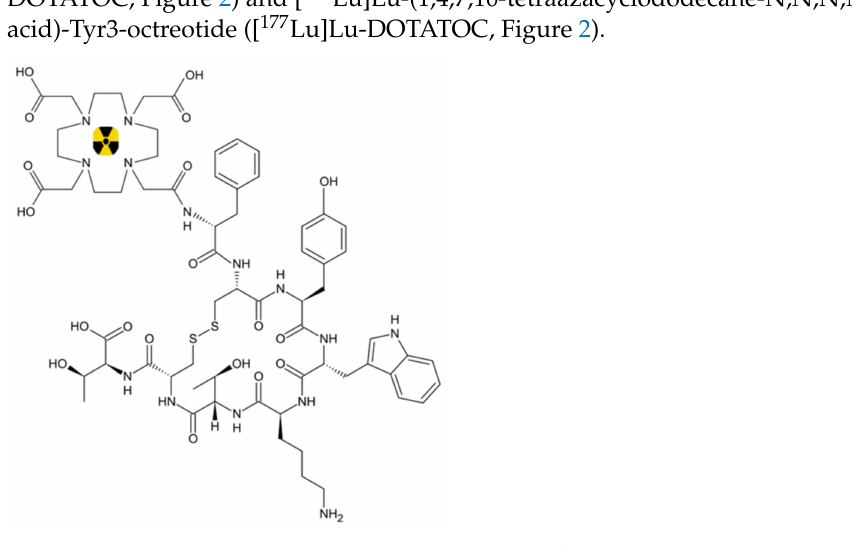
Figure 2. Chemical structure of [ 90 Y]Y-DOTATOC and [ 177 Lu]Lu-DOTATOC = 90 Y or 177 Lu. DOTATOC has higher affinity for type 2 somatostatin receptors (SST-R2), with IC 50 = 14 ± 2.6 nM, and lower for type 5 (SST-R5) and type 3 (SST-R3), with IC 50 = 393 ± 84 nM and IC 50 = 880 ± 324 nM respectively [19,22].